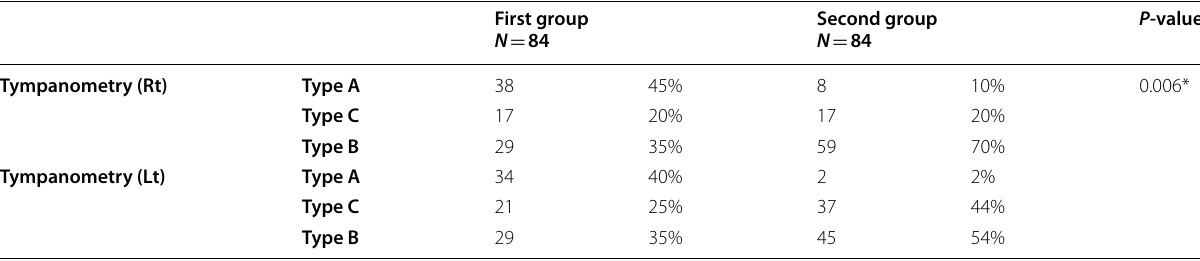
Chi-square test: * statistically significant difference